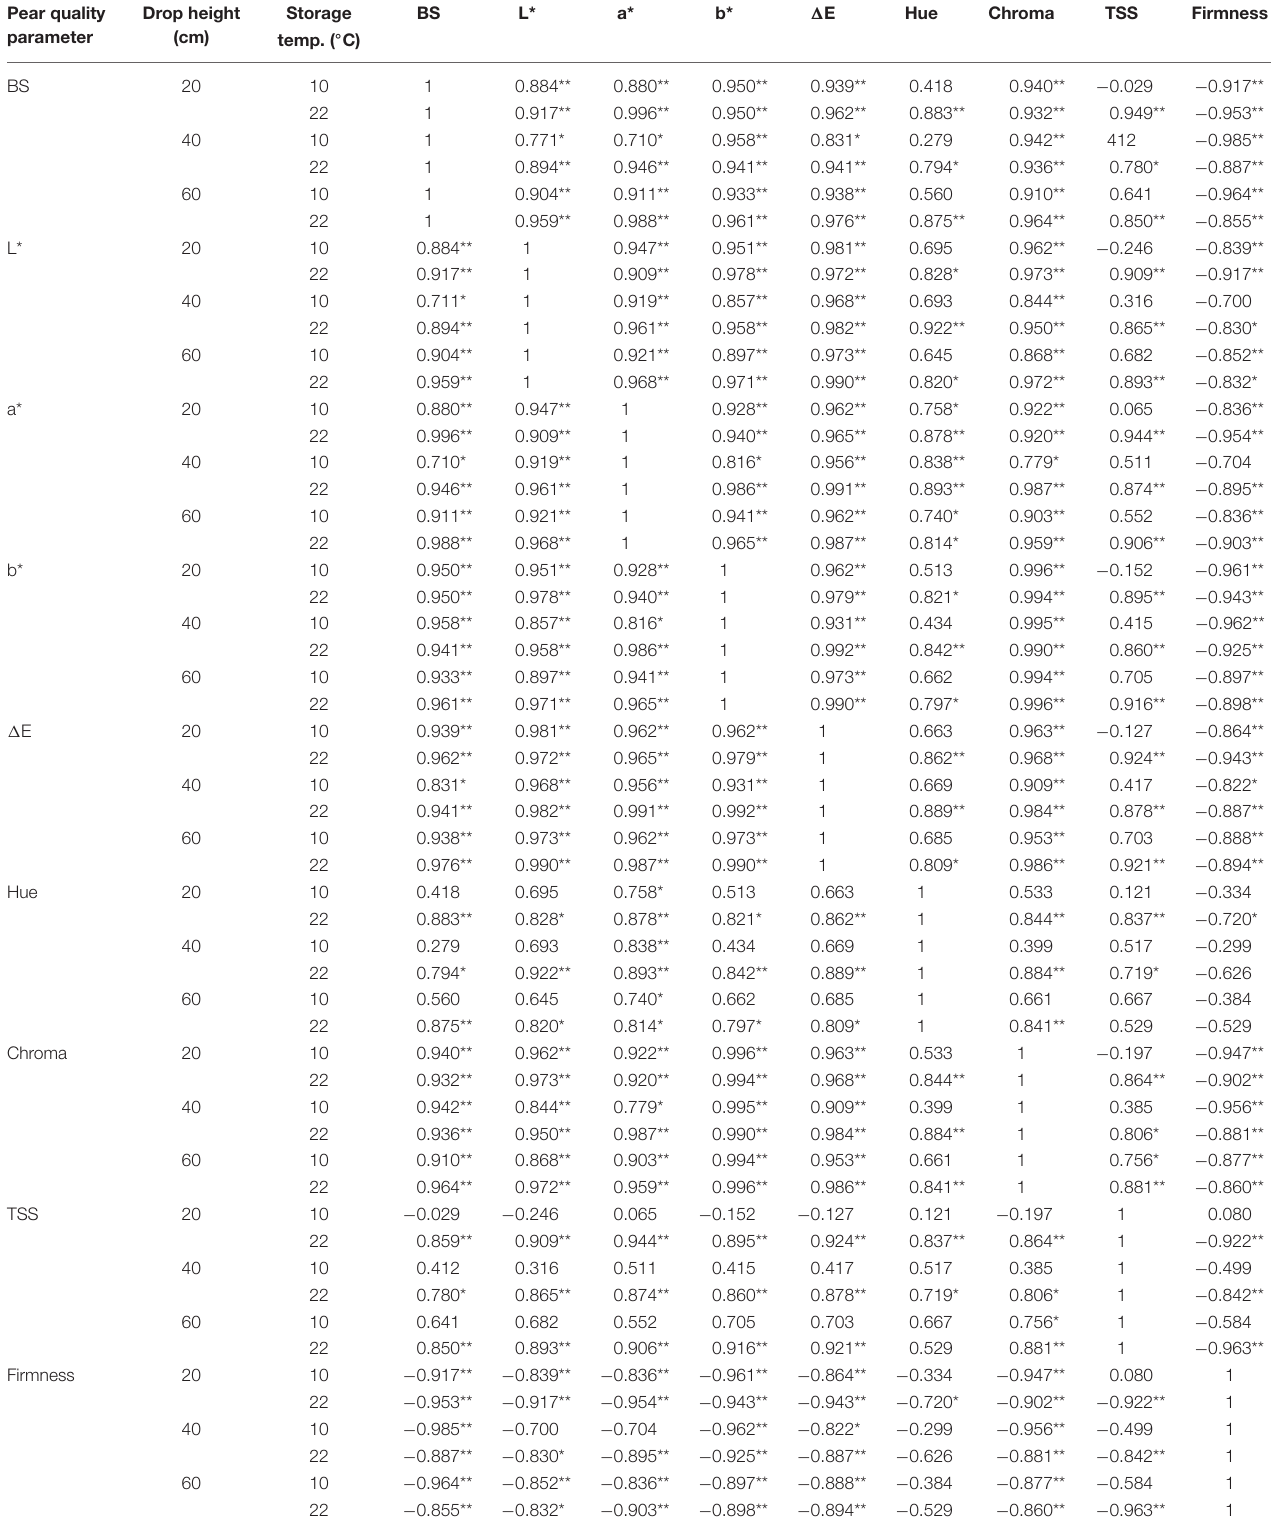
TABLE 5 | Pearson correlation coefficients ( r ) ( n = 8) between bruise susceptibility (BS), color space values [L * , a * , b * , total color change ( 1 E), chroma, and hue], firmness, and TSS on pear stored at 10 and 22 ◦ C and impacted by a steel ball from three drop heights. Pear quality Drop height parameter